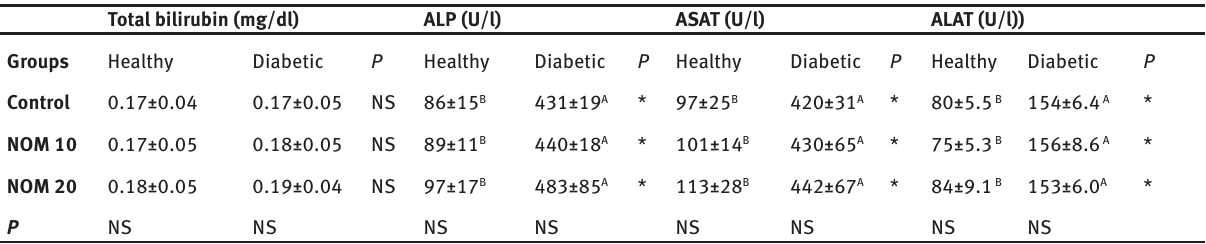
Table 5: Effects of Nannochloropsis oculata microalgae (NOM) at rates of 10 and 20mg.kg -1 of body weight on the serum concentrations of total bilirubin, alkaline phosphatase (ALP), aspartate amino transferase (ASAT) and alanine amino transferase (ALAT) in healthy and diabetic rats.